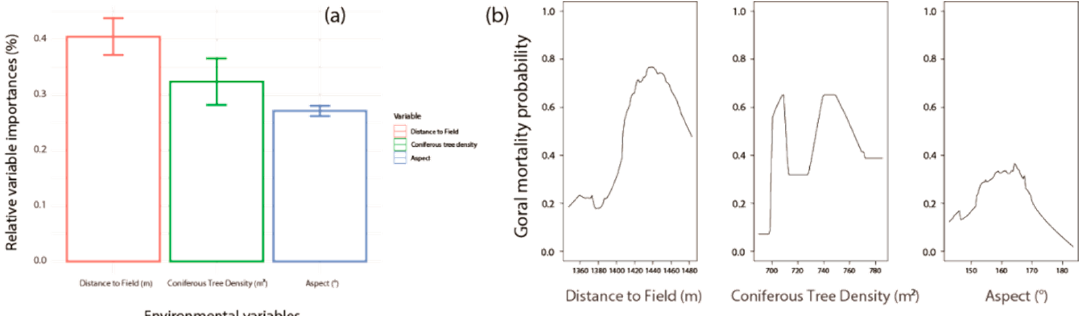
Figure 6. Three selected variables of the ensemble model with the algorithms of Random Forest, Maxent, and Domain. ( a ) Relative variable importance (%) and ( b ) relationship between goral presence probabilities and the three relevant factors. A large cluster of areas with a high goral mortality rate is located in the central longitudinal regions (Figure 7a). Within the cluster, some areas were fragmented because the map excluded the south-east facing areas (Figure 7b).